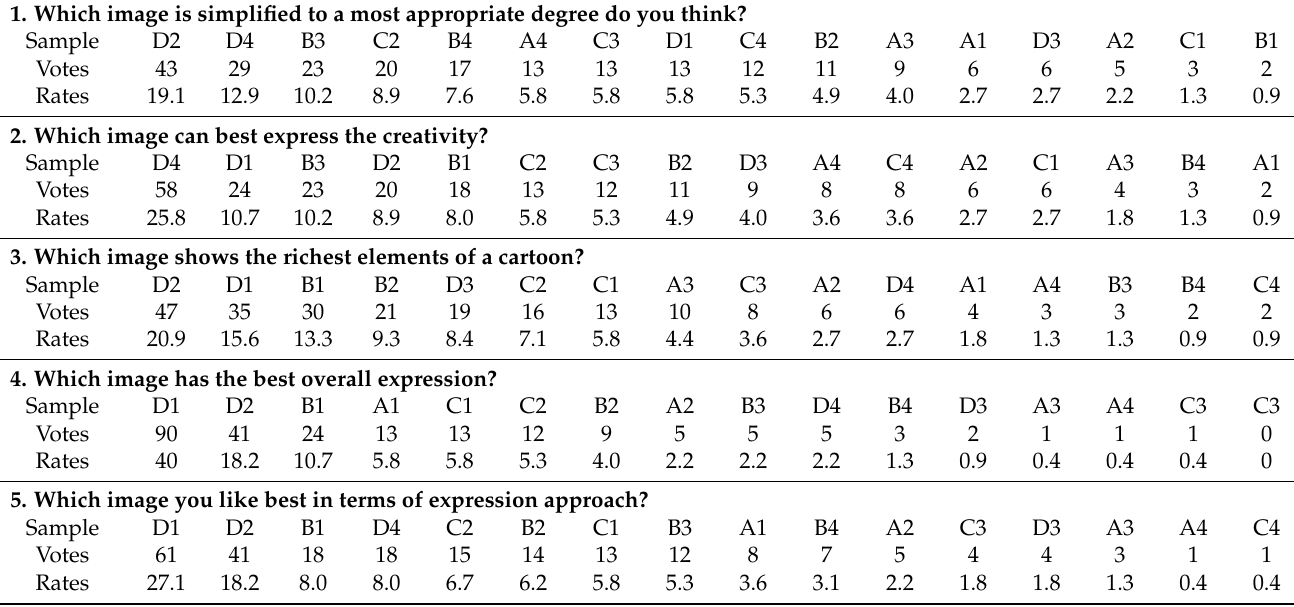
Table 4. Voting status of 9 questions in evaluation of preferences I and